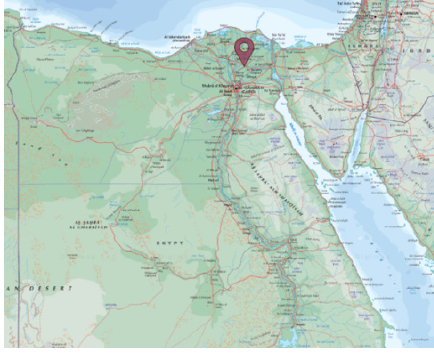
Figure 3. Location of Zagazig, coordinates: 30°34 ′ N 31°30 ′ E [23].